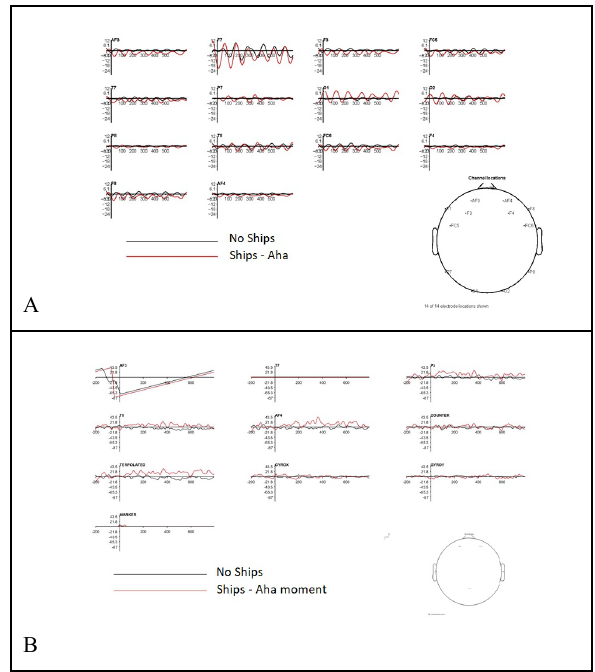
Figure 7. Grand average signals for Emotiv Epoc(A) and Insight(B) recording ERP experiment.